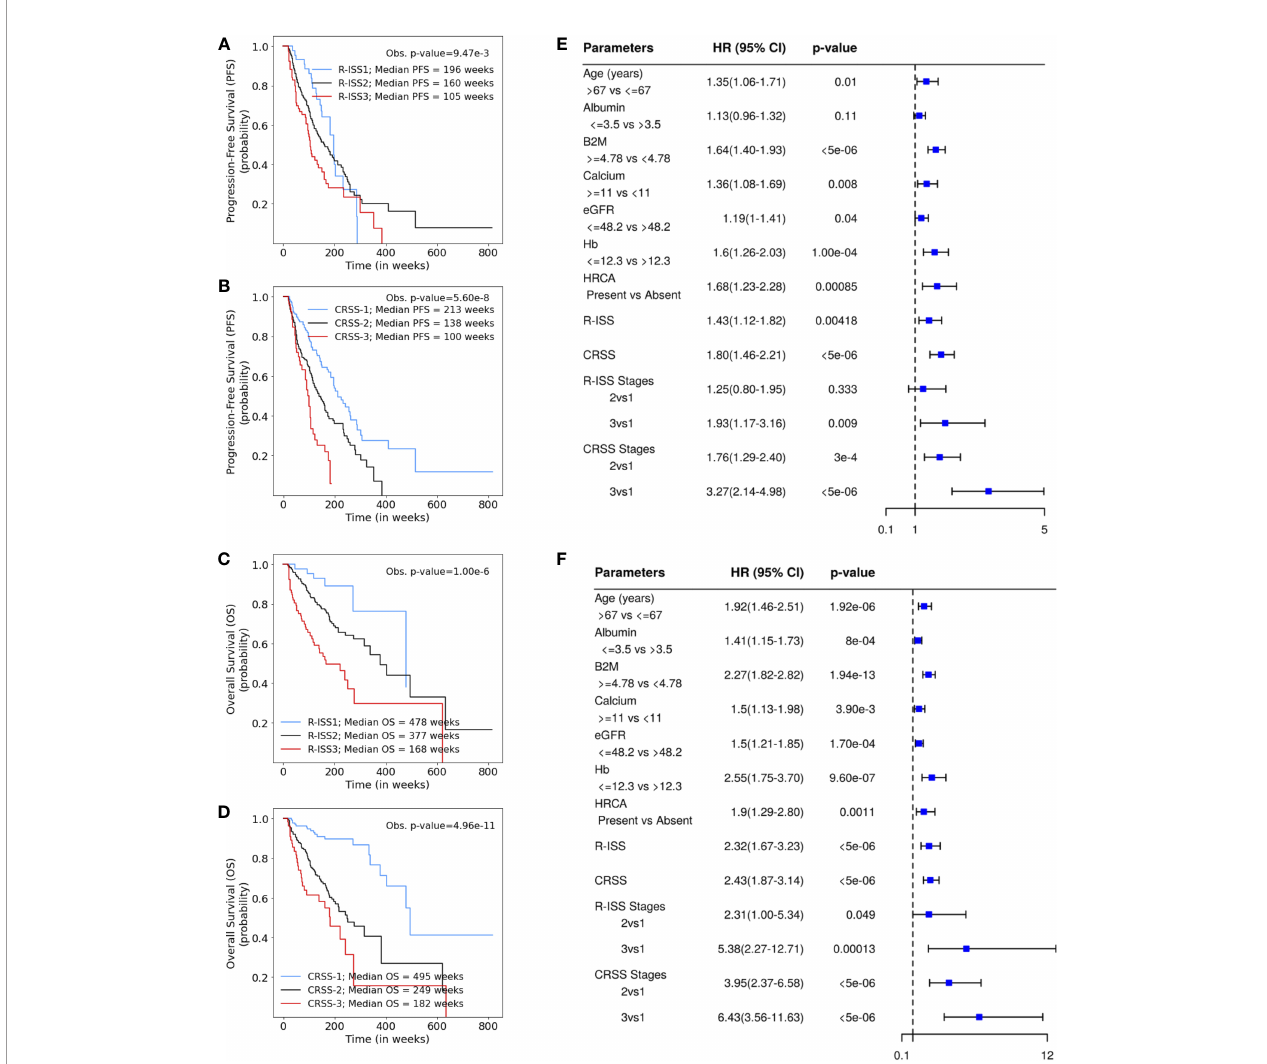
FIGURE 2 | (A, B) Progression-free survival in patients with multiple myeloma (MM) from the MMIn cohort ( n = 1,070) strati fi ed by the Revised International Staging System (R-ISS) ( n = 355) and the proposed CRSS ( n = 384), respectively. R-ISS1 is the low-risk stage, R-ISS2 is the intermediate-risk stage, and R-ISS3 is the high- risk stage. Median progression-free survival (PFS) for R-ISS1, R-ISS2, and R-ISS3 are 196, 160, and 105 weeks, respectively. The observed p -value obtained after performing a log-rank test on R-ISS is 9.47e-3. Similarly, CRSS-1 is the low-risk stage, CRSS-2 is the intermediate-risk stage, and CRSS-3 is the high-risk stage. Median PFS for CRSS-1, CRSS-2, and CRSS-3 are 213, 138, and 100 weeks, respectively. The observed p -value obtained after performing a log-rank test on CRSS is 5.60e-8. (C, D) Overall survival in patients with MM from the MMIn cohort ( n = 1,070) strati fi ed by the R-ISS ( n = 355) and CRSS ( n = 384), respectively. Median overall survival (OS) for R-ISS1, R-ISS2, and R-ISS3 are 478, 337, and 168 weeks, respectively. The observed p -value obtained after performing a log-rank test on R-ISS is 1.00e-6. Median OS for CRSS-1, CRSS-2, and CRSS-3 are 495, 249, and 182 weeks, respectively. The observed p -value obtained after performing a log-rank test on CRSS is 4.96e-11. (E, F) Univariate Cox hazard analysis on the prognostic factors — age, albumin, beta-2 microglobulin ( b 2M), calcium, estimated glomerular fi ltration rate (eGFR), hemoglobin, and high-risk cytogenetic abnormalities (HRCA) — for PFS and OS, respectively. Hazard ratios for all the parameters except HRCA were calculated on complete data ( n = 1,070) for the MMIn dataset. Hazard ratio for HRCA and the risk-staging models were found using the data for which HRCA information was present ( n = 384 for the MMIn